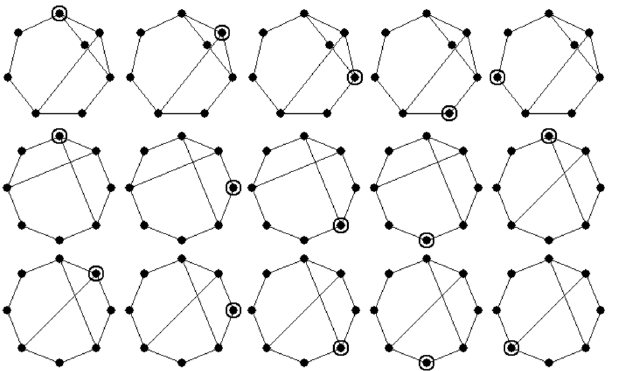
Figure 7. A part of the 8-link 1-DOF kinematic chain inversions.